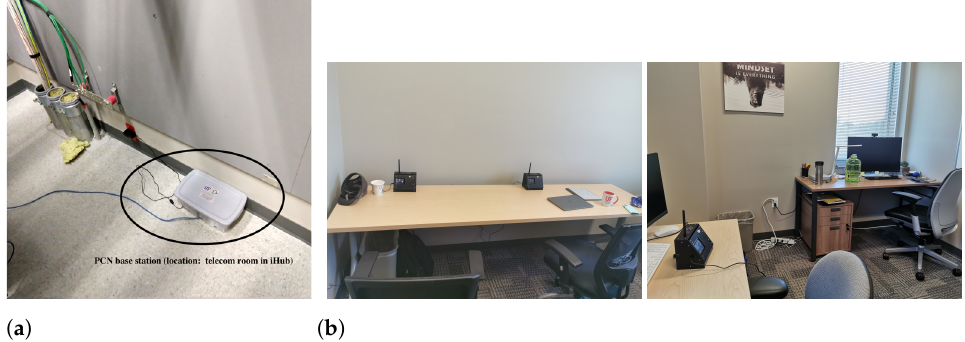
Figure 6. Base station and a few PCFNs, after deployment in iHub. ( a ) Base station in iHub; ( b ) a few PCFNs, as installed in offices in the iHub